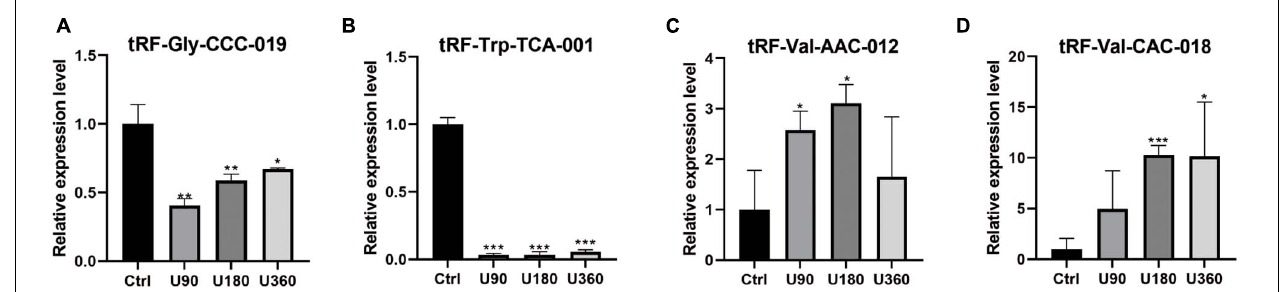
FIGURE 5 | Validation of the four selected tsRNAs using RT-qPCR verification for four tRFs & tiRNAs. Compared with the control group A, (A,B) tRF-Gly-CCC-019 and tRF-Trp-TCA-001 were down-regulated; (C,D) tRF-Val-AAC-012 and tRF-Val-CAC-018 were up-regulated. The data were normalized using the